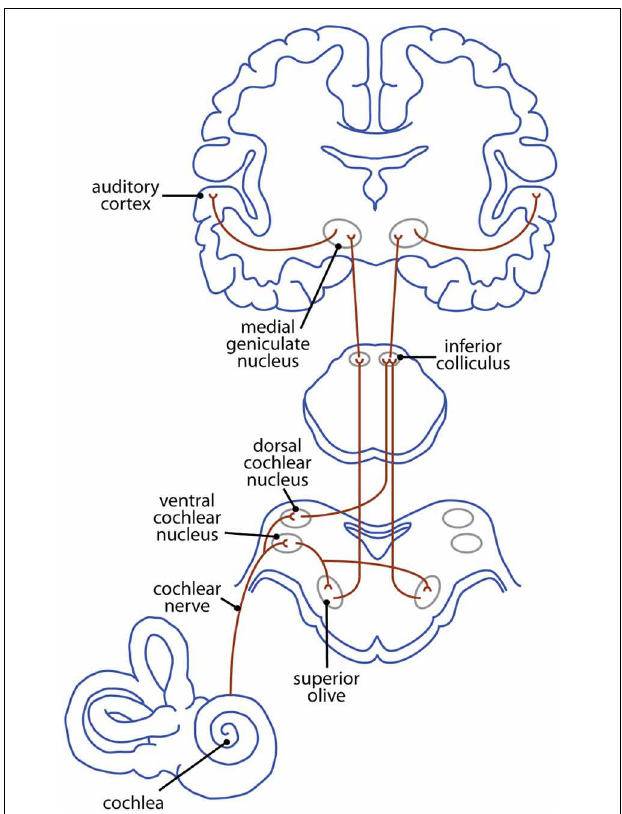
FIGURE 3 | The ascending mammalian auditory pathway—from cochlea to